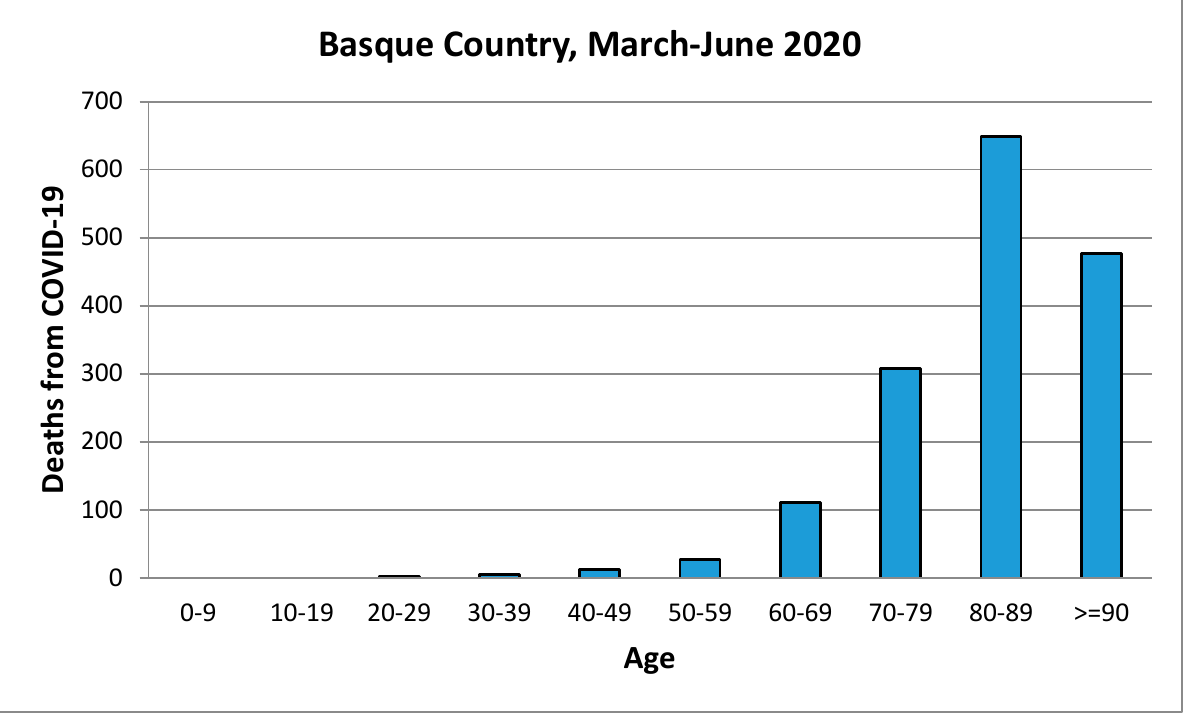
Figure 5. Ages of those who died during the first wave of COVID-19, in Basque Country. Source: A. Erkoreka [16].